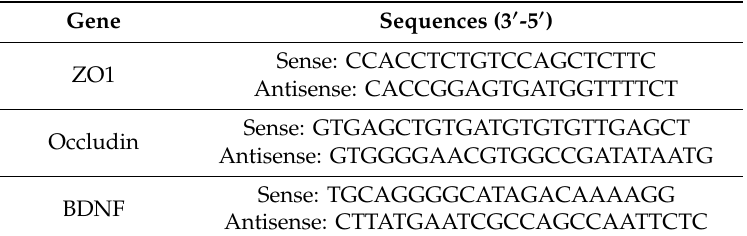
Table 1. The sequences for the primers used for real-time